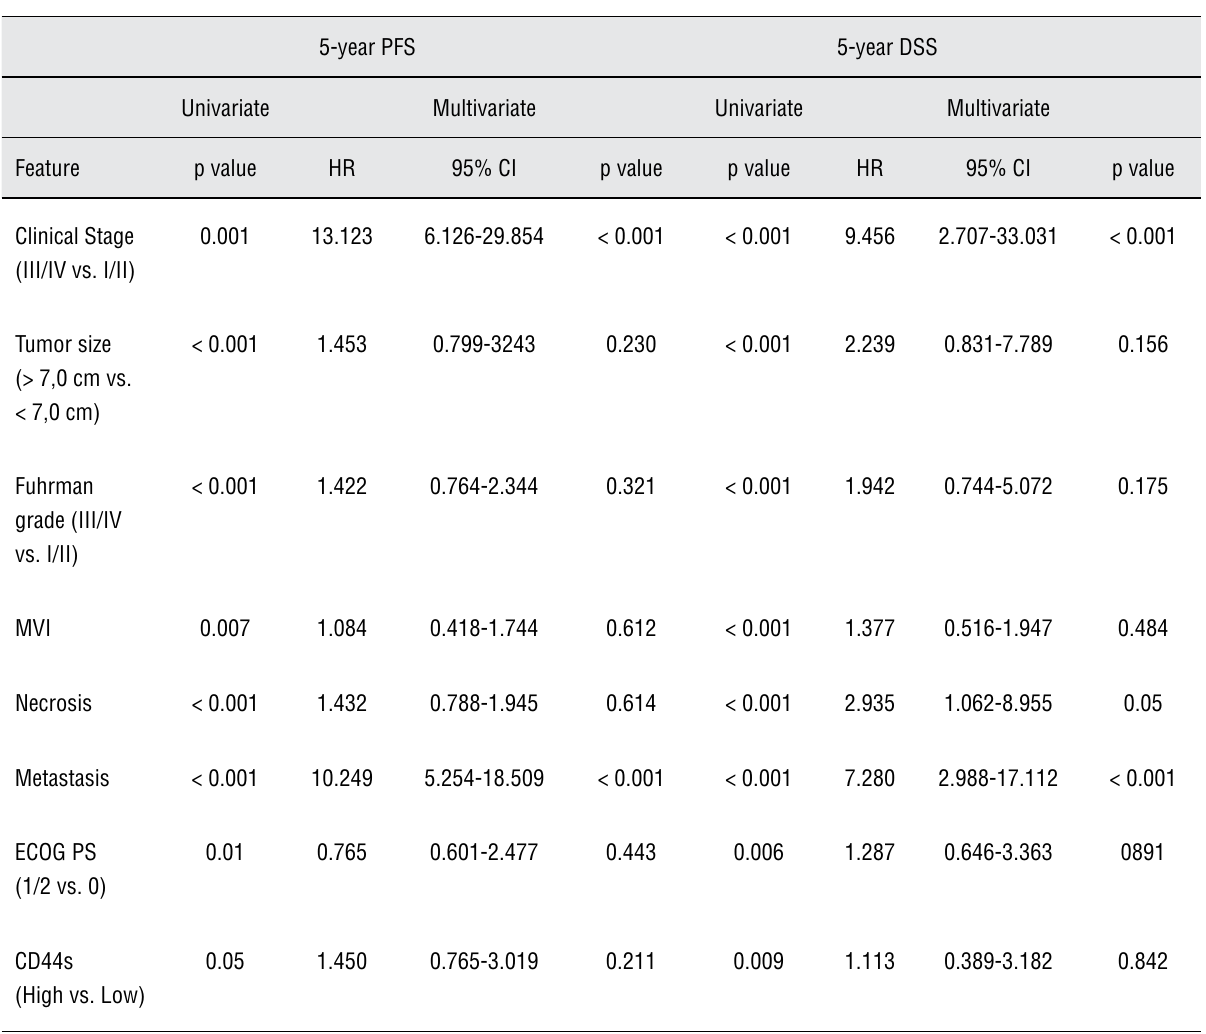
Table 2 - cox regression analysis of DSS and